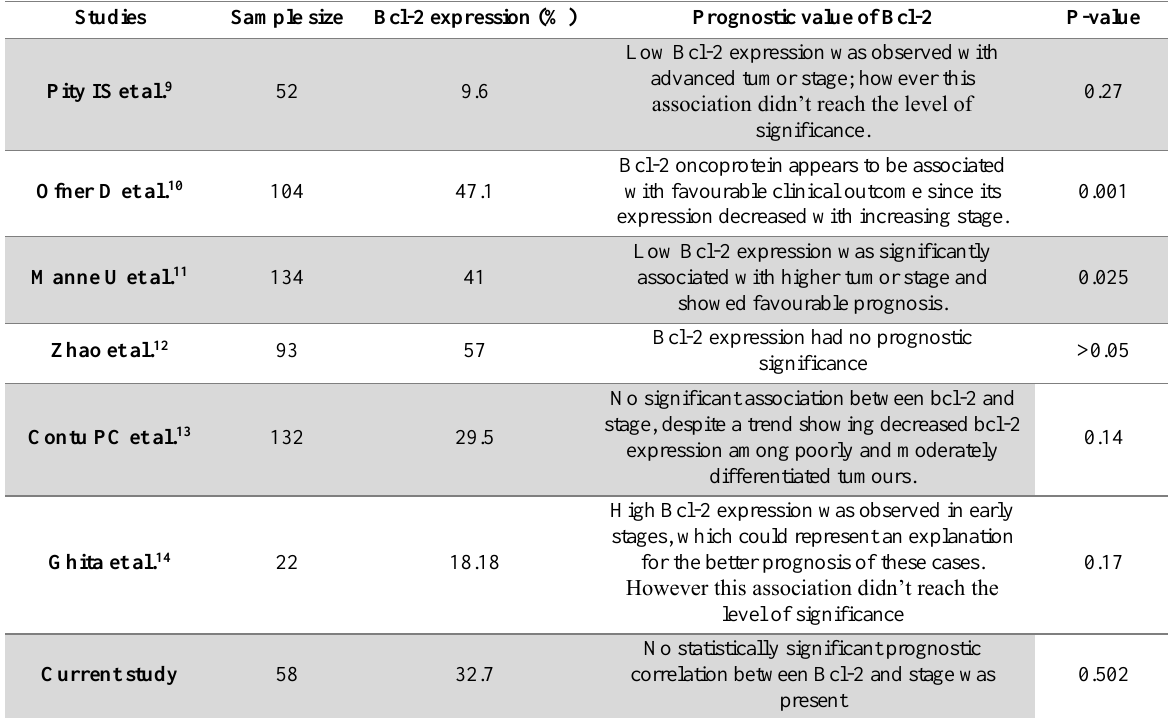
Table 5. Bcl-2 Expression with respect to histologic